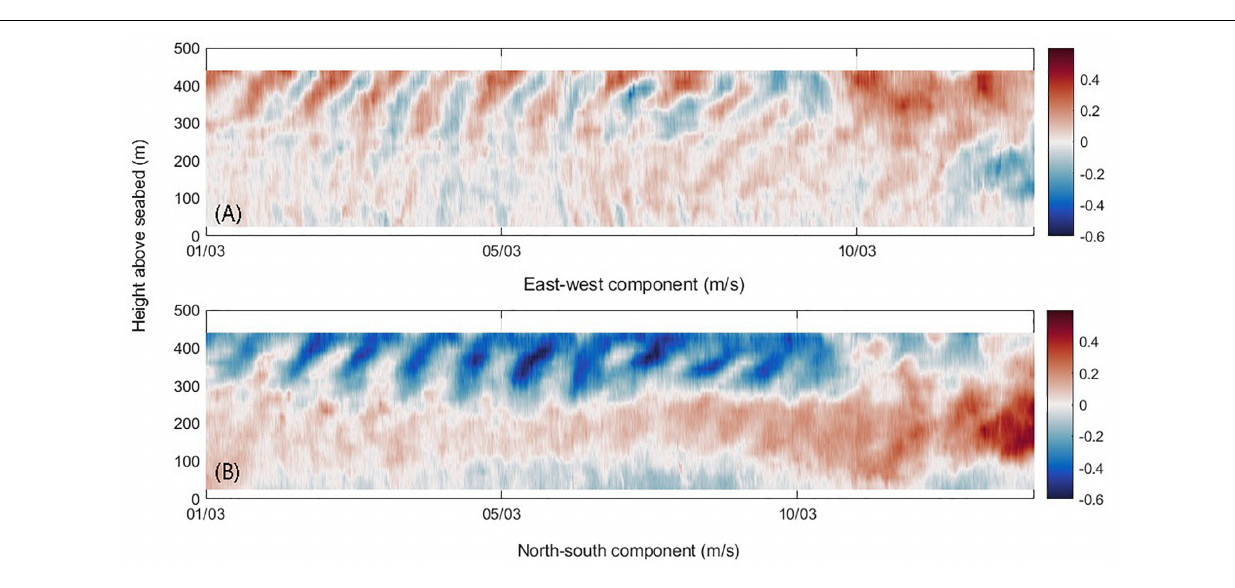
FIGURE 7 | Time series of (A) east–west component; and (B) north–south component of currents recorded March 1–15, 2015 within the Perth Canyon at 500 m water depth (see location in Supplementary Figure 9 ). Positive values represent currents to the east and to the